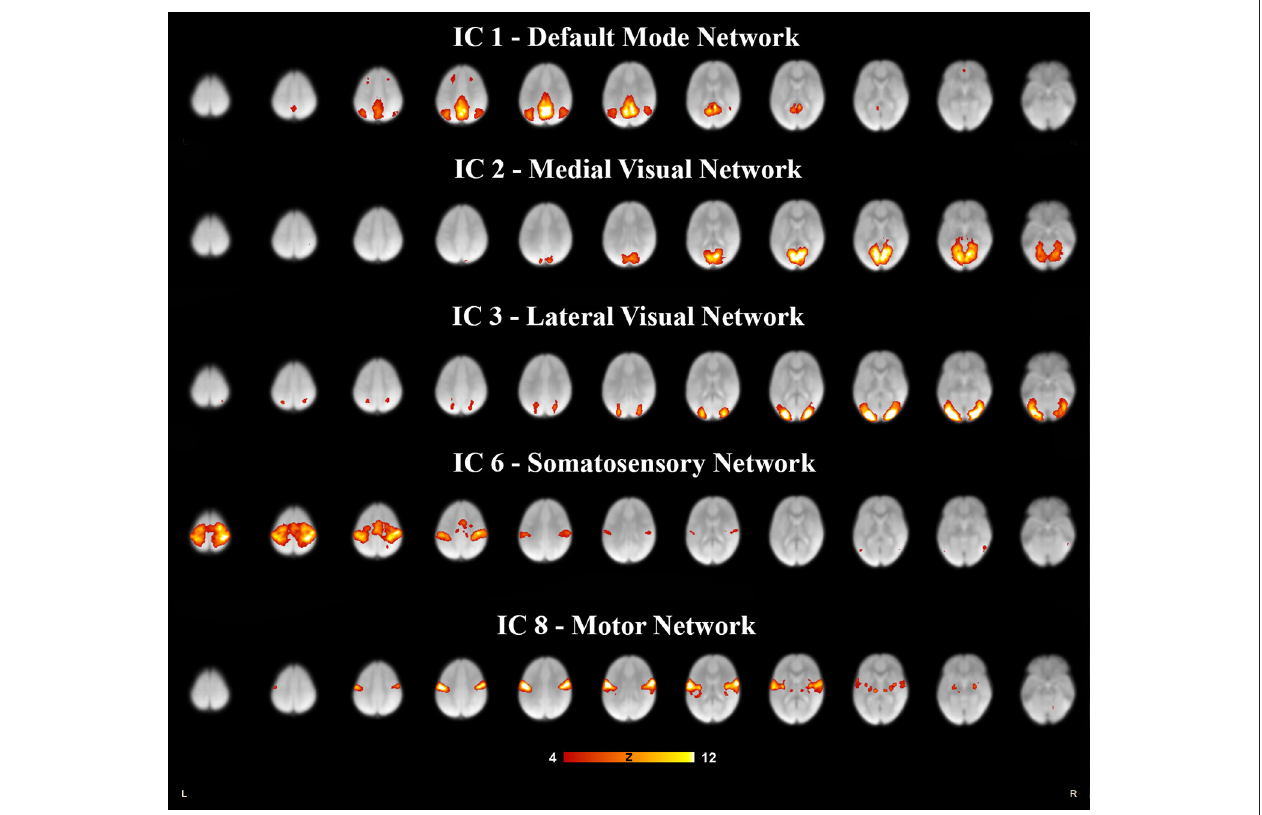
FIGURE 1 | Five resting state networks derived from 6- to 7- year olds rs-fMRI selected for relevance and high correlation. Each independent component was paired to the components derived in adults ( Smith et al., 2009), for spatial overlap which was quantified as a spatial cross correlation coefficients. The networks with a spatial cross-correlation coefficient (r) ≥ 0.204 relating to P < 0.0001 are depicted here. The images are shown in neurological convention, with the left side of the brain is represented in the left side of the figure. All overlays were made from the z-statistical images and thresholded to 4 < Z <